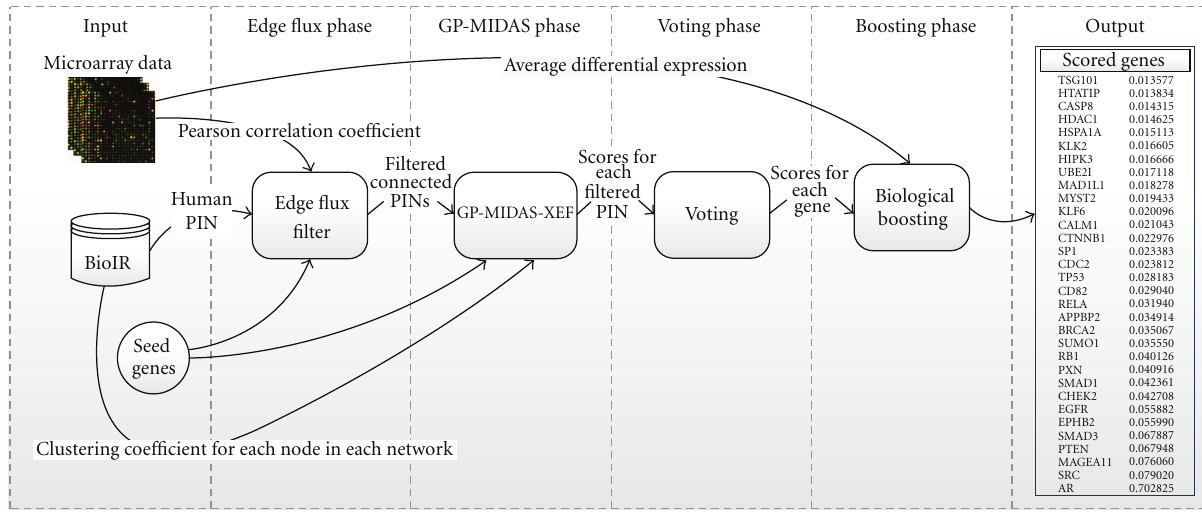
Figure 2: GP-MIDAS-VXEF workflow.